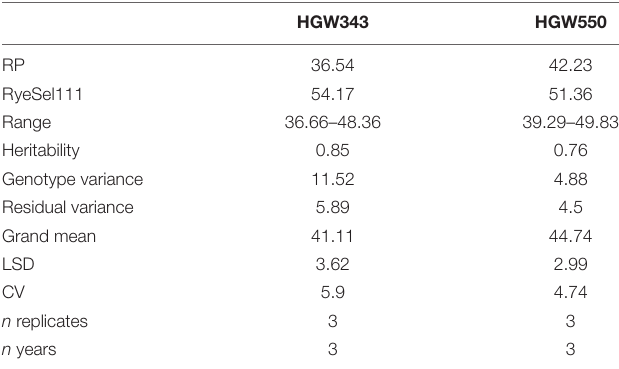
TABLE 1 | Statistical analysis of HGW343 and HGW550 progenies across F 3 , F 4 , and F 5 generations planted in RBD